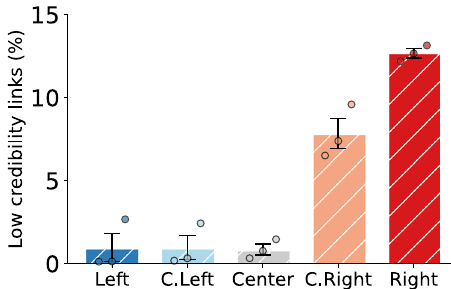
Fig. 4 Exposure to low-credibility content. The bars express the proportions of low-credibility links in the home timelines of different drifter groups. Error bars indicate standard errors ( n = 3 drifters in each group). Source data are provided as a Source data fi le.